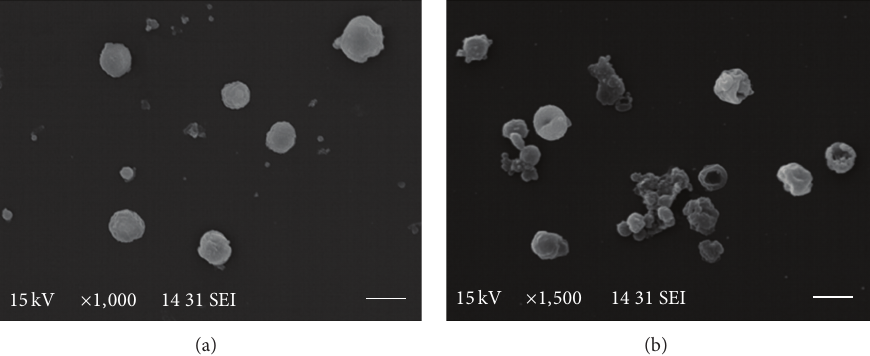
Figure 3: Scanning electron microscopy of E. granulosus isolated larval cells incubated in vitro with 10 𝜇 g/mL of thymol during 7 days. (a) Control. (b) Cells treated with thymol. Bar = 5 𝜇 m.